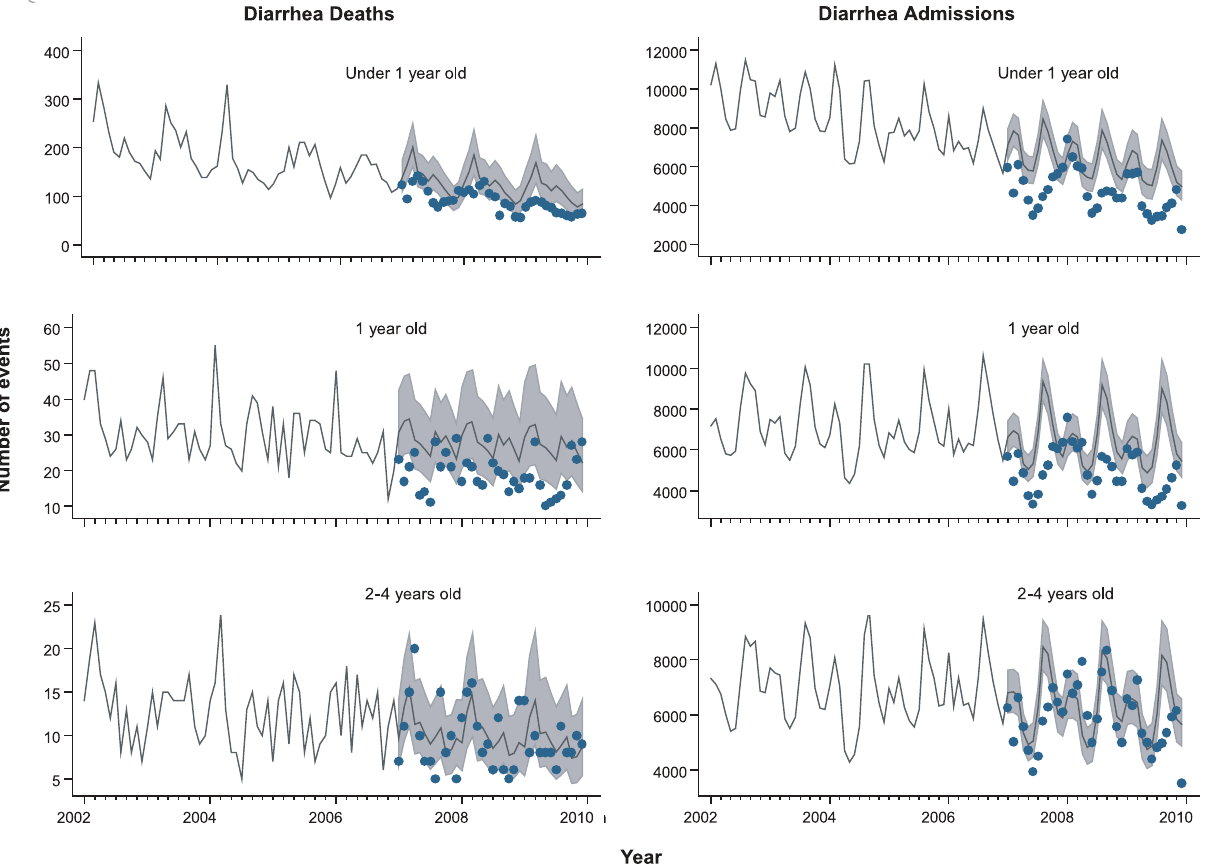
Figure 1. Trends in childhood diarrhea deaths and admissions in Brazil. Each analysis examines trends from 2002–2009, by age, including comparison of observed events (blue dots) after rotavirus vaccination (2007 to 2009) in Brazil with expected events (solid line) and 95% CIs (gray shaded area) in the absence of vaccination. Expected number of events and 95% CIs are based on predictions from regression models fitted to historic data from each region (2002 to 2005).